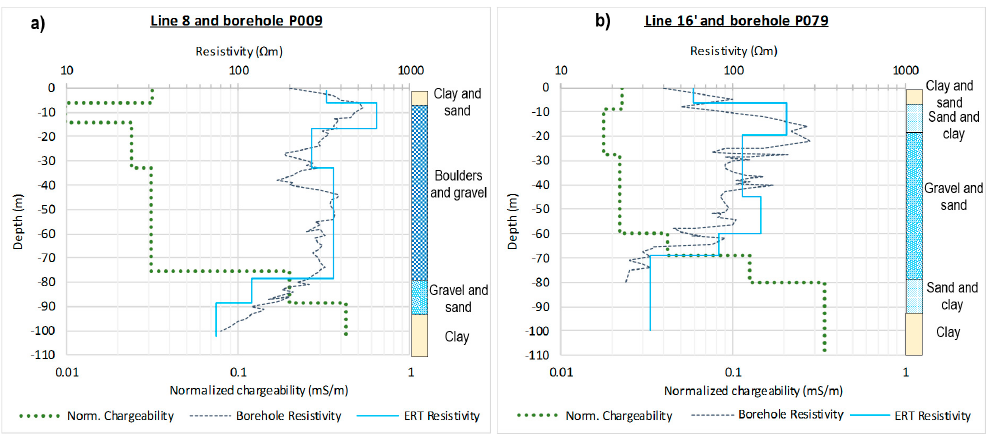
Figure 5. ERT resistivity is plotted versus the normalized chargeability and the resistivity from well-logging at the same position. ( a ) Line 8 and borehole P009; ( b ) Line 16’ and borehole P079.